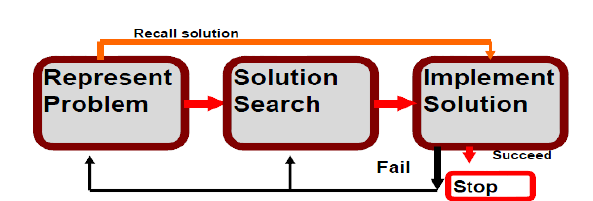
Figure 1: A Model of the Problem Solving Process (Gick,